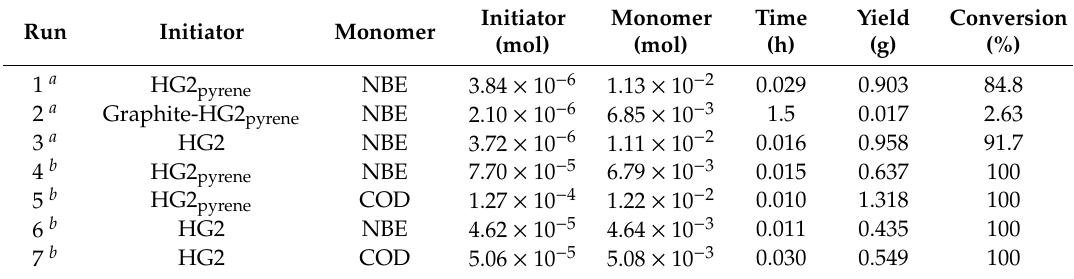
Table 1. Ring Opening Metathesis Polymerization of the 2-norbornene and 1,5-cyclooctadiene. Run Initiator Monomer